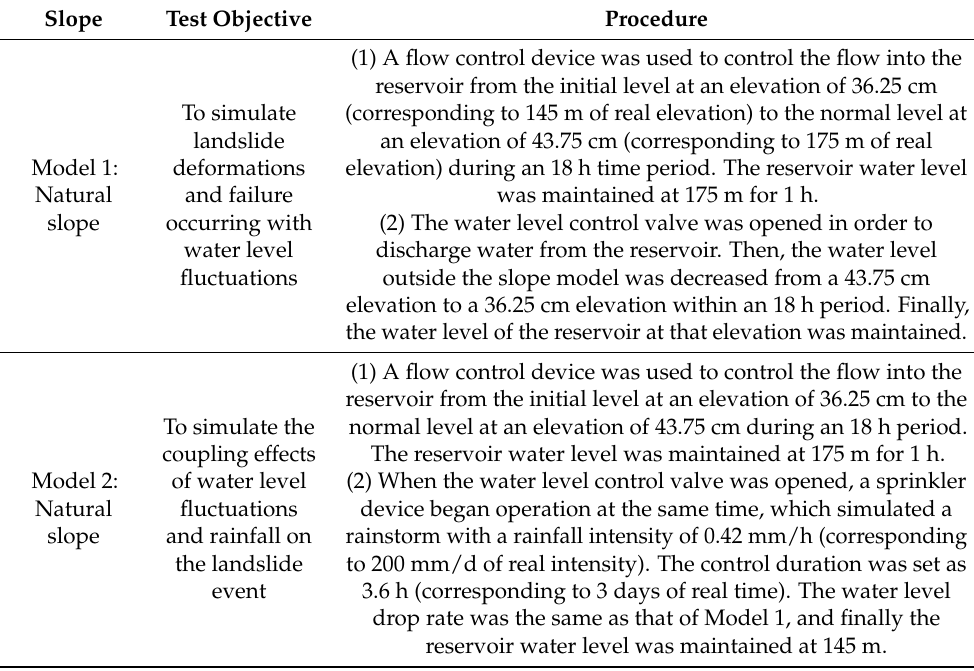
Figure 7. Construction of the physical simulation models: ( a ) Slide bed; ( b ) Slide surface; ( c ) Slide mass; ( d ) Entire model. Table 3. Testing procedures for the